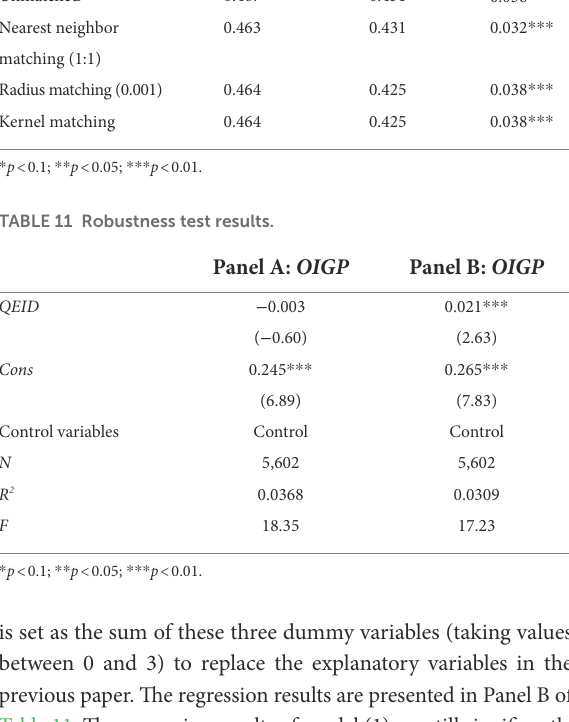
TABLE 10 PSM test results. Treated Controls ATT